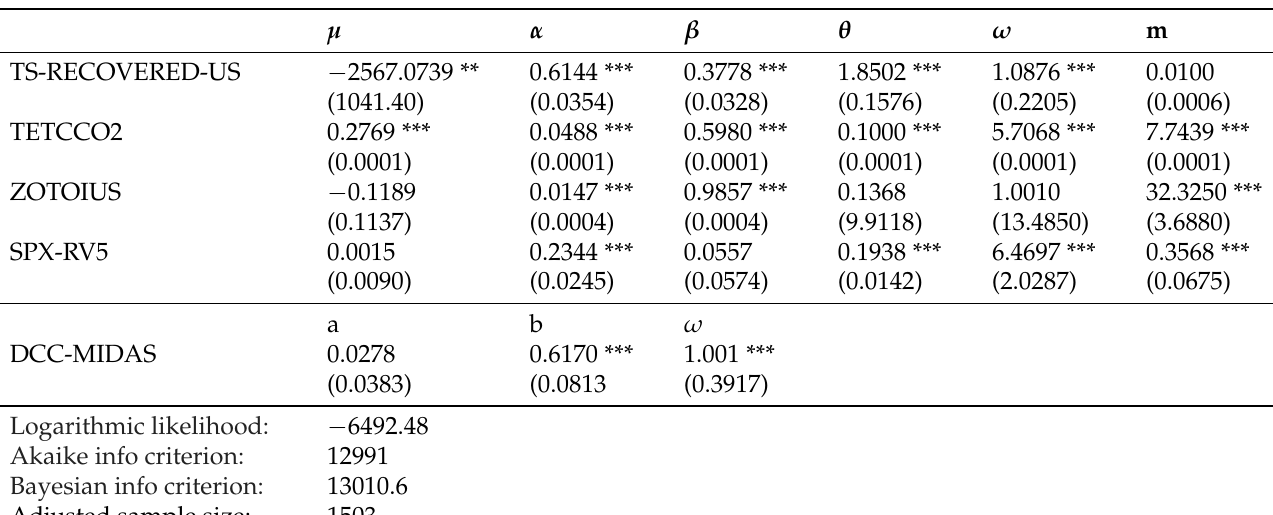
Table 6. Dynamic Conditional Correlation with Mixed Data Sampling (DCC-MIDAS) estimates when introducing COVID-19 recovered cases to the baseline composed of Total Fossil Fuels CO 2 emissions, Total Industrial Production Index, and S&P 500